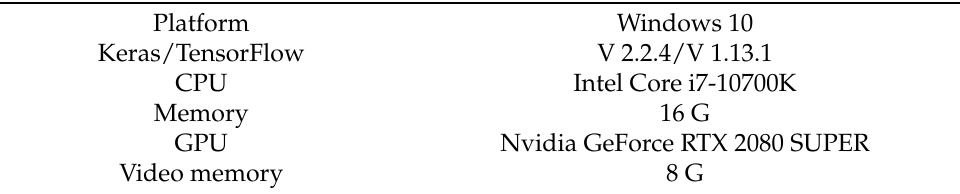
Table 2. The basic experimental environment